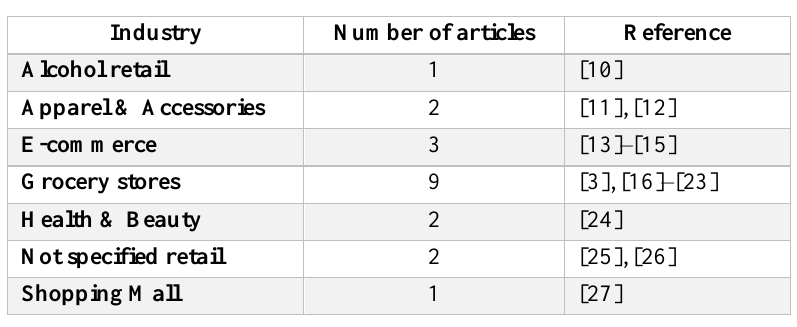
Table 1. Industry prevalence in the reviewed